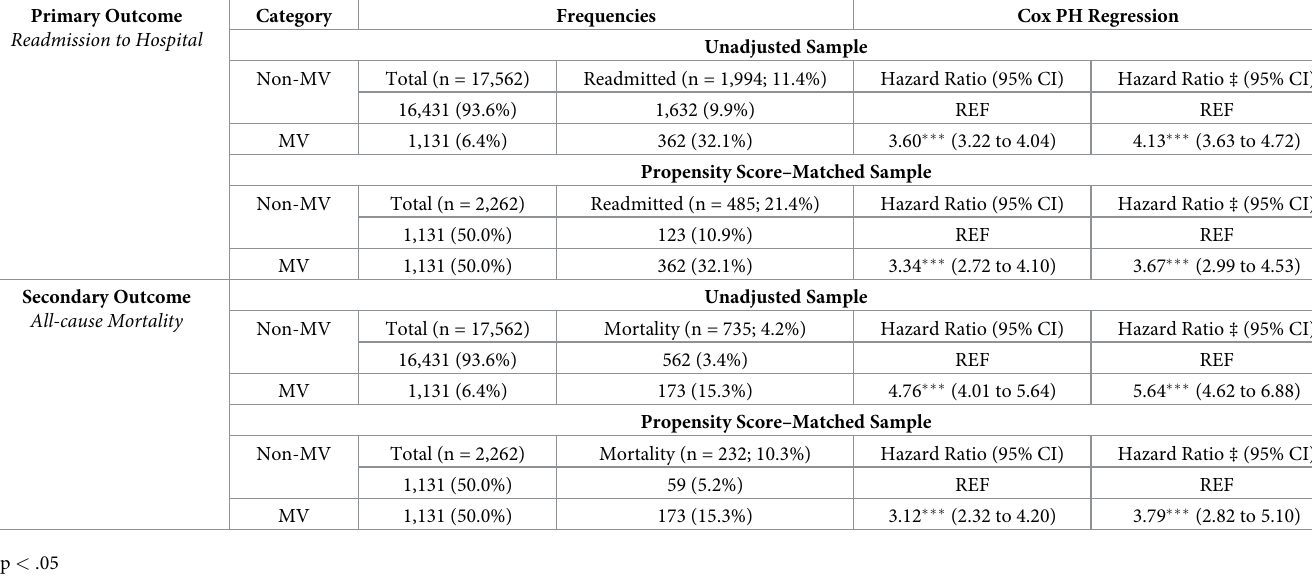
Table 2. Analyses for primary outcome (readmission to hospital) and secondary outcome (all-cause